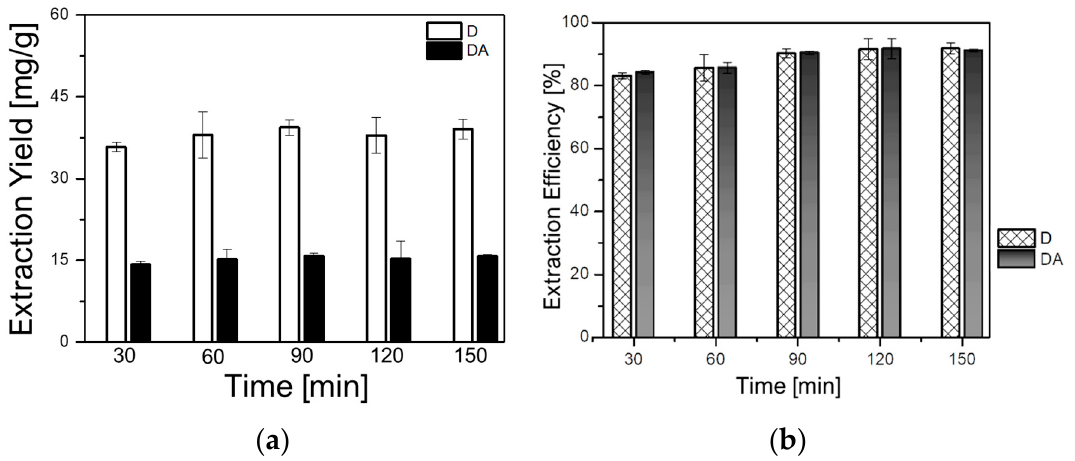
Figure 4. Effect of the extraction time on: ( a ) extraction yields of D and DA and ( b ) extraction efficiencies of D and DA.